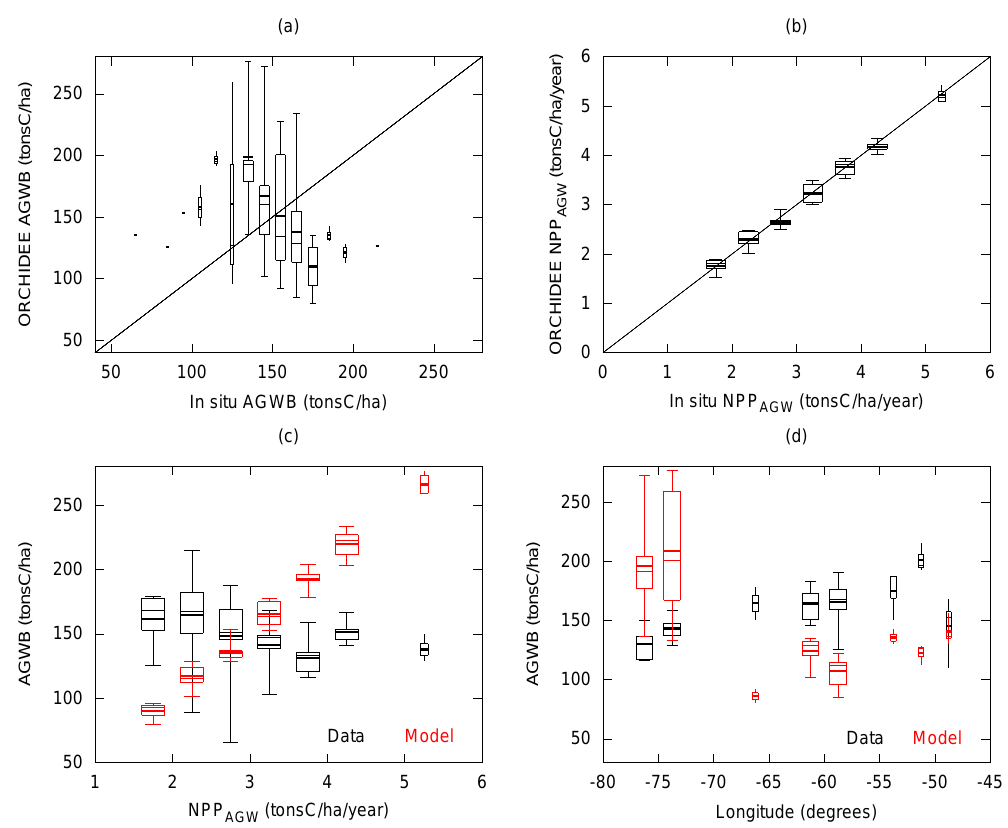
Fig. 4. Impact of forcing NPP AGW while keeping a constant mortality rate. Same legend than Fig. 2 except that we use the only 72 sites for which we have both ground measurements of NPP AGW and